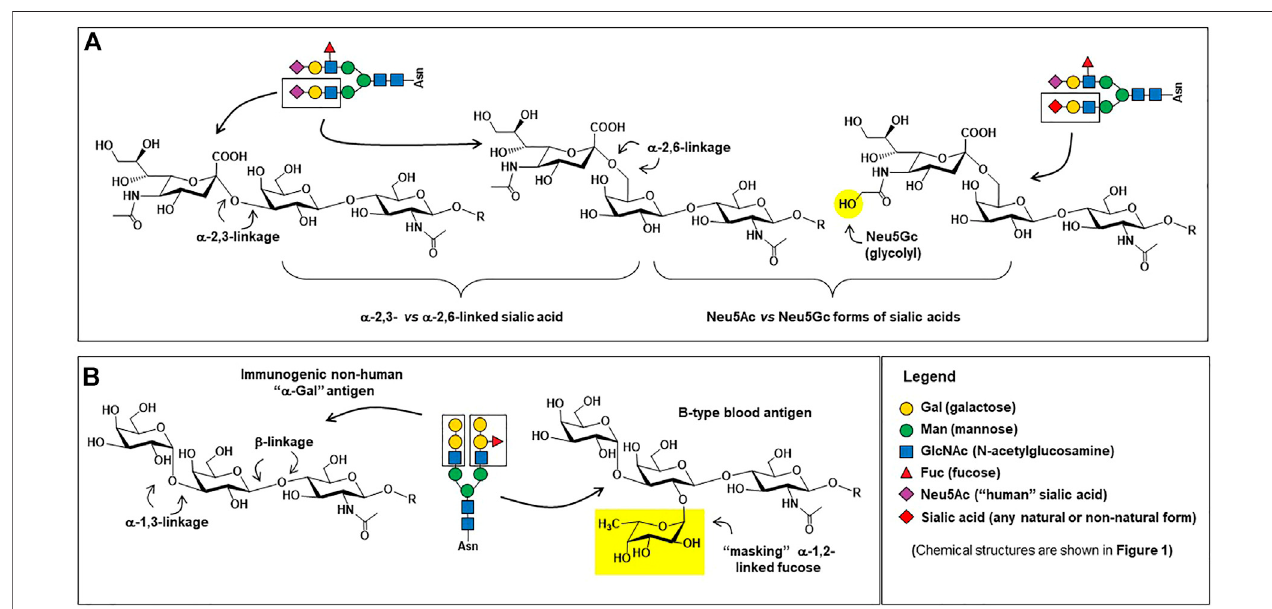
FIGURE 4 | Carbohydrate epitopes relevant to therapeutic antibodies. (A) Sialic acid is found in human proteins in both α 2,3-linkages (left) and α 2,6-linkages (center); α 2.6-linked sialic acid is critical for providing IgG antibodies with anti-in fl ammatory characteristics (Kaneko et al., 2006) whereas α 2,3-linked sialic acid are effective at preventing ASPGR clearance (Ellies et al., 2002). The presence of the N-glycolylneuraminic acid (Neu5Gc, right) form of sialic acid on proteins produced in non-human mammalian cells can be pro-in fl ammatory (Tangvoranuntakul et al., 2003; Samraj et al., 2015), which may or may not be desired in a therapeutic protein. (B) The structure of the “ α -Gal ” trisaccharide epitope (left) is a major safety concern ( Section 5.2.1 ); in human cells, the terminal alpha-linked galactose is not added to a glycan until the penultimate masking α 1,2-linked fucose (right) is installed, preventing the synthesis of the “ naked ” immunogenic α -Gal epitope. Incidentally, the tetrasaccharide shown comprises the B-type blood antigen, whose present is a quality control parameter in IVIg therapy ( Section 5.1.2 ).